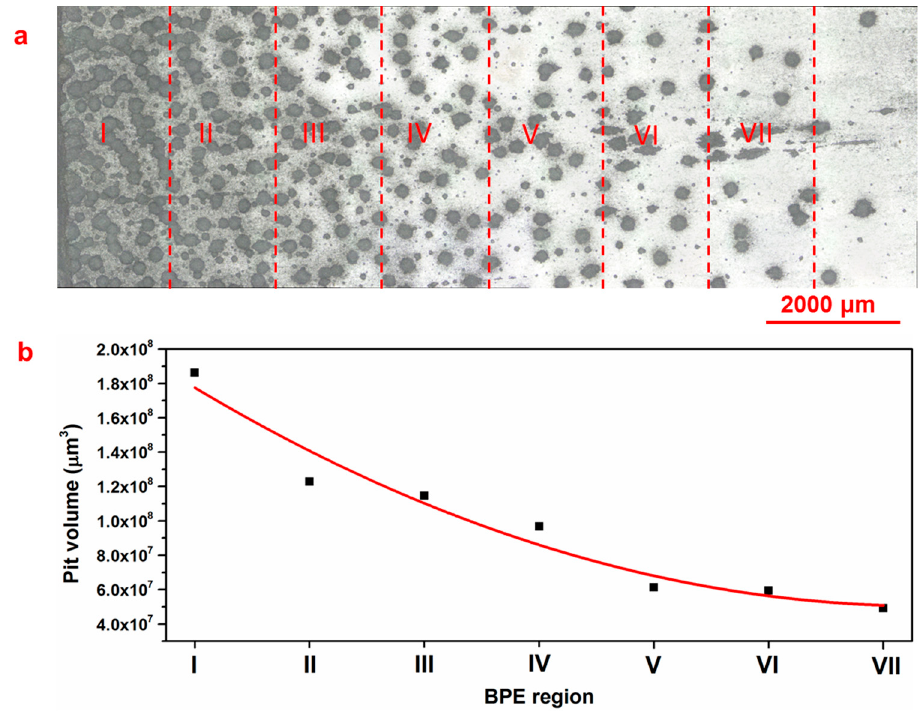
Figure 11. ( a ) Overview of the seven pit covered regions, with ( b ) the corresponding pit volumes measured using laser confocal microscopy.